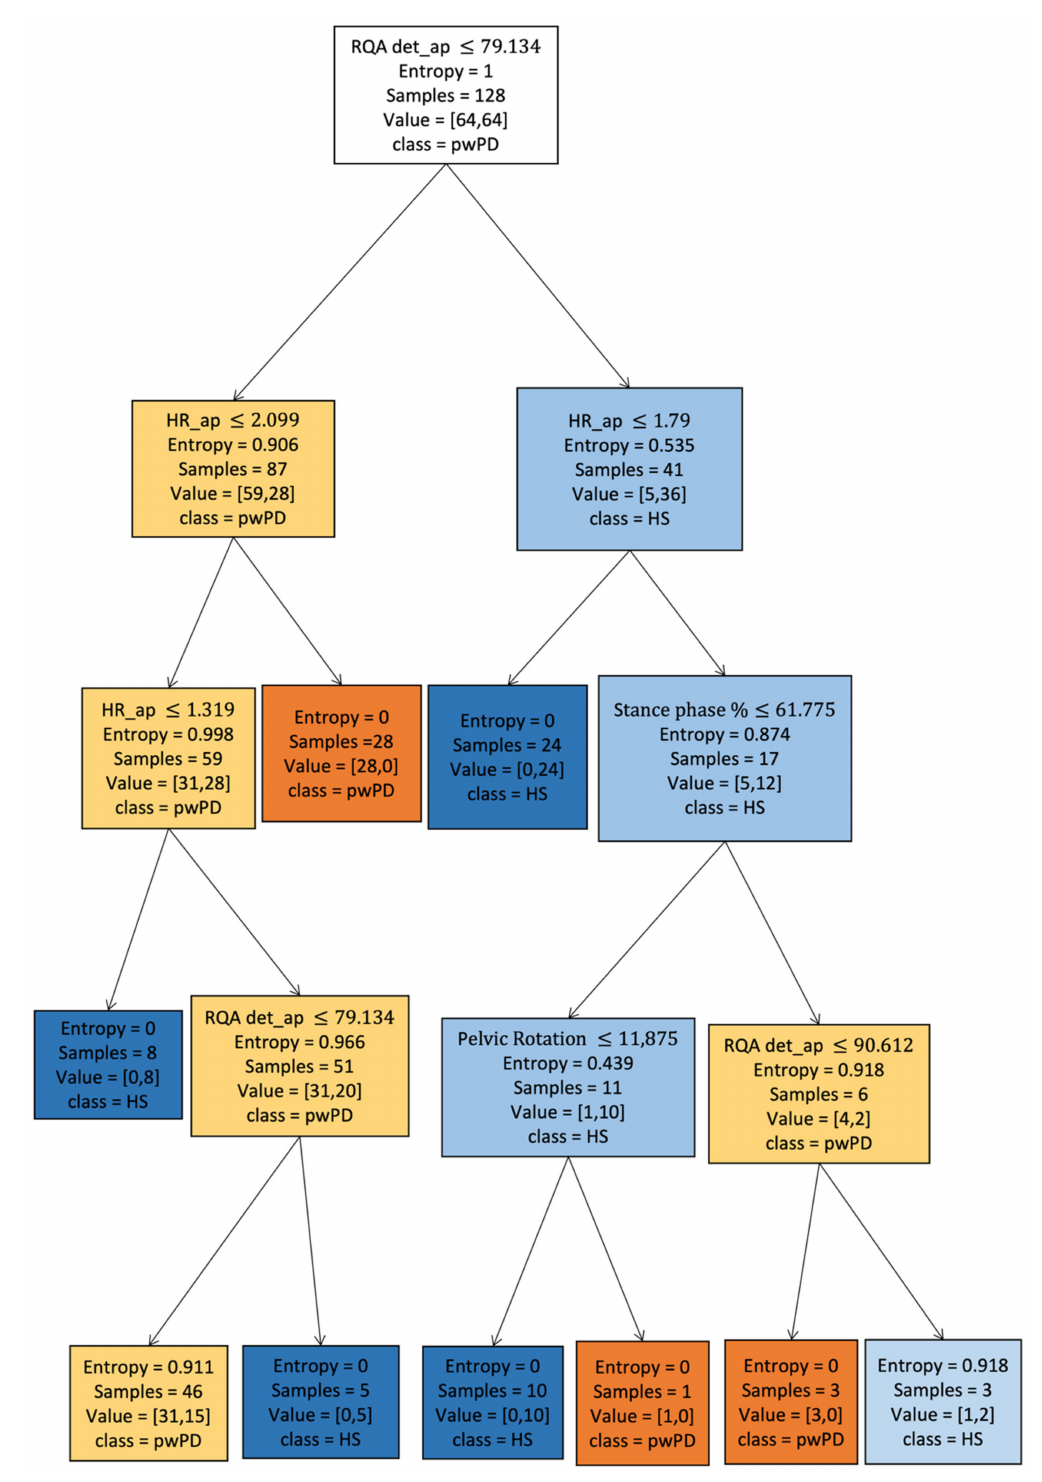
Figure 10. Decision tree graphical visualization. Graphical representation of our decision tree with maximum depth of five and used impurity criterion of entropy. In the decision-making process of the decision tree, we can observe the importance of the parameter RQAdet_ap to discriminate between Parkinson’s and healthy subjects in root node. As can be observed from the internal nodes, HR_ap, and RQAdet_ap are very important in the forecasting process: HR_ap, harmonic ratio anteroposterior; RQAdet_ap, % determinism in the recurrence quantification analysis anteroposterior; pwPD, people with Parkinson’s disease; HS, healthy